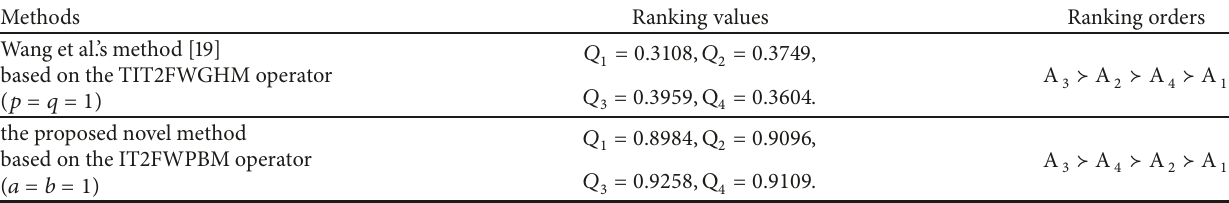
Table 10: Ranking orders of the different methods for Example